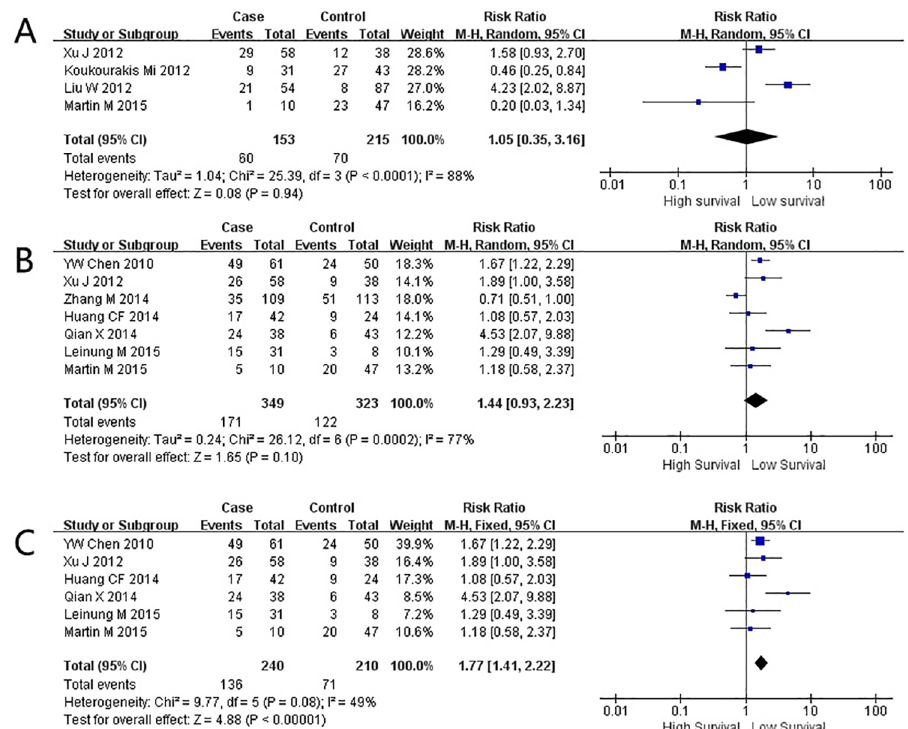
Fig 3. Meta-analysis for adjusted relative risk (RR) of the disease-free survival (DFS) or overall survival (OS) compared to the ALDH1 + subgroup. Forest plot of RR among includedstudies for the DFS of the ALDH1 + group compared to ALDH1 - group (A). Forest plot of RR for the OS (B) and adjustedOS (C) of the ALDH1 + group compared to ALDH1 - group.